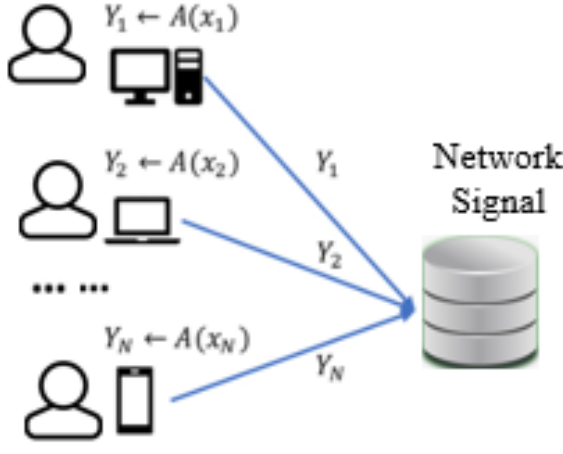
Figure 4. Collection of the Network